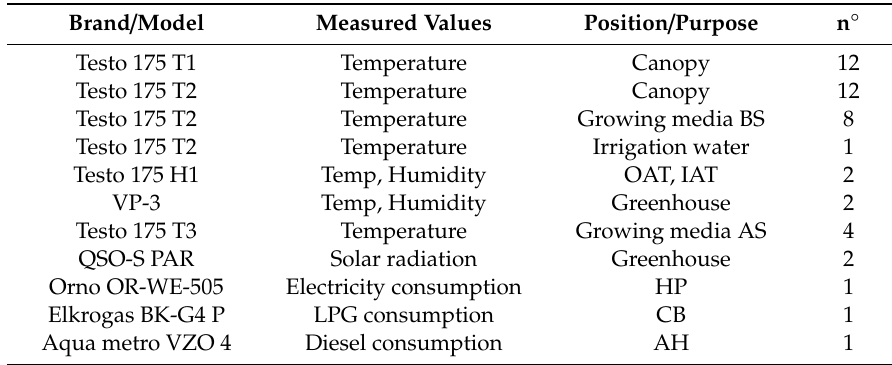
Table 3. Instruments. BS: basal-heating greenhouse section; OAT: greenhouse outside air temperature; IAT: greenhouse inside air temperature; AS: air-heating greenhouse section; HP: heat pump; CB: condensing boiler; AH: air heater. Brand / Model Measured Values Position / Purpose n ◦ Testo 175 T1 Temperature Canopy 12 Testo 175 T2 Temperature Canopy 12 Testo 175 T2 Temperature Growing media BS 8 Testo 175 T2 Temperature Irrigation water 1 Testo 175 H1 Temp, Humidity OAT, IAT 2 VP-3 Temp, Humidity Greenhouse 2 Testo 175 T3 Temperature Growing media AS 4 QSO-S PAR Solar radiation Greenhouse 2 Orno OR-WE-505 Electricity consumption HP 1 Elkrogas BK-G4 P LPG consumption CB Aqua metro VZO 4 Diesel consumption